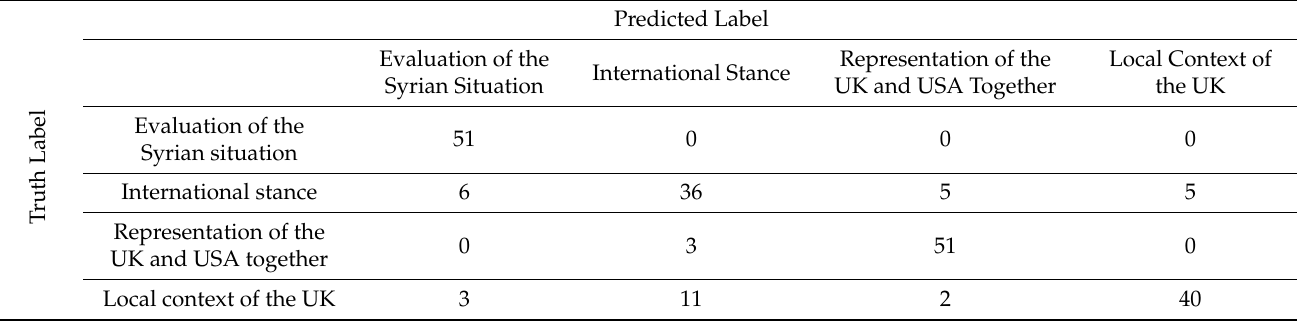
Table 6. Confusion matrix for thematic analyses using LSTM